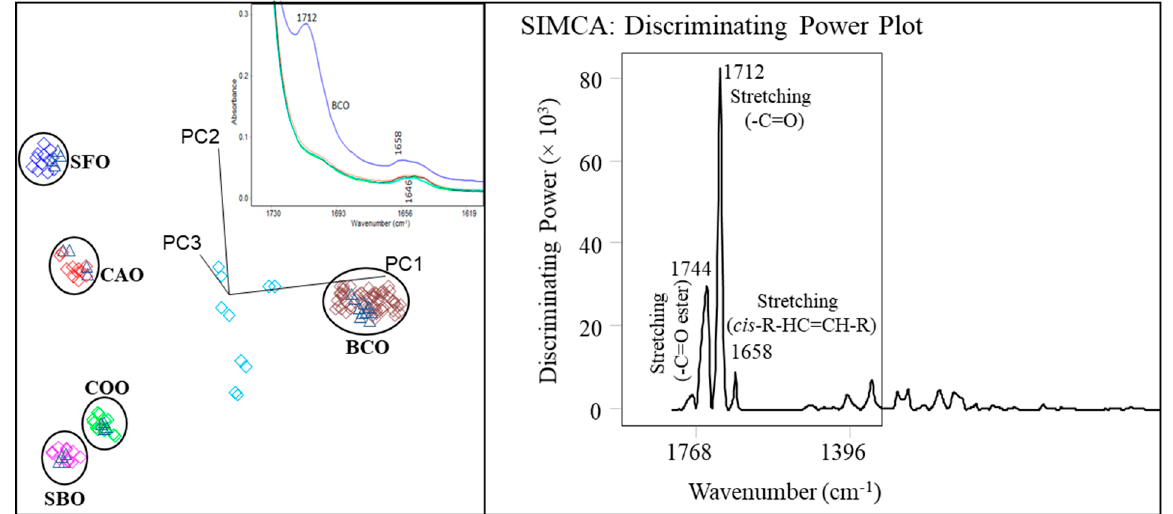
Figure 2. Soft independent modeling of class analogy—3D projection and discriminating power by SIMCA obtained from portable FT-MIR. BCO: black cumin oil; CAO: canola oil; COO: corn oil; SBO: soybean oil; SFO: sunflower oil; triangles: validation; unclassified: adulterated black cumin oils; PC1-2-3: Principal Component.